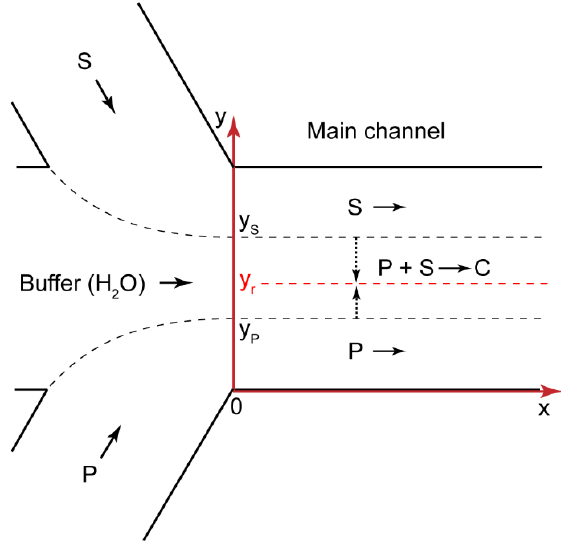
Figure 5. Geometry of a Ψ‐ type microfluidic chip. P—polyelectrolyte, S—surfactant, C—complex; y r is the radial coordinate of the reaction front; y P and y S are polymer and surfactant flow boundaries, respectively.